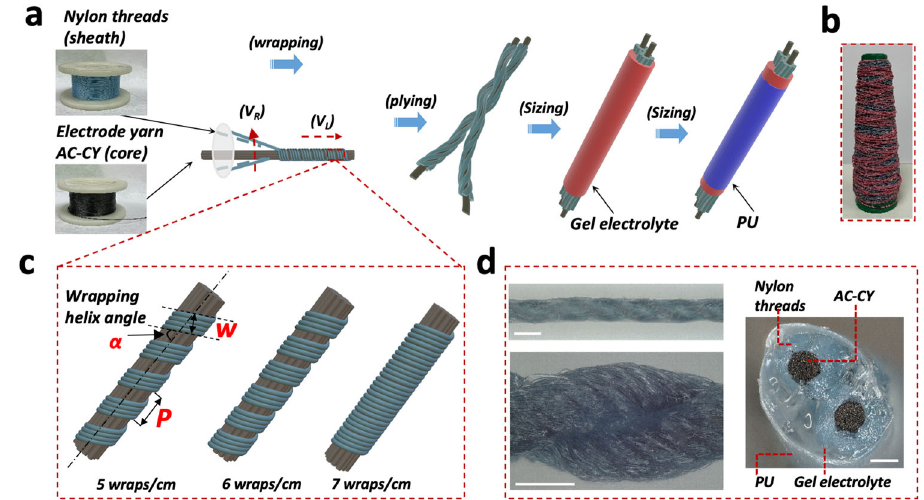
Fig. 1 Depiction of our TYCs with schematics, photos, and optical microscopic images. a Schematic diagram of the fabrication process of TYCs with separator threads incorporated; b Tens of meters long TYCs on a spool (the color comes from different nylon separator threads incorporated); c Schematic illustration the wrapping density of separator threads in AC-CYs; d Optical microscopic images showing the side and cross-sectional views of our TYCs (scale bar in left top: 1 mm; left bottom: 500 µm; right: 250